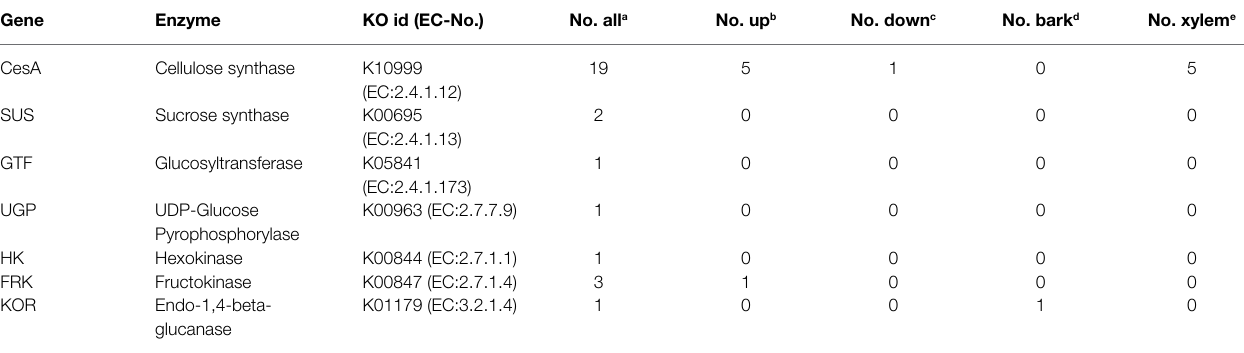
TABLE 4 | Candidate differentially expressed genes involved in cellulose biosynthesis-related metabolism. Gene Enzyme KO id (EC-No.) No. all